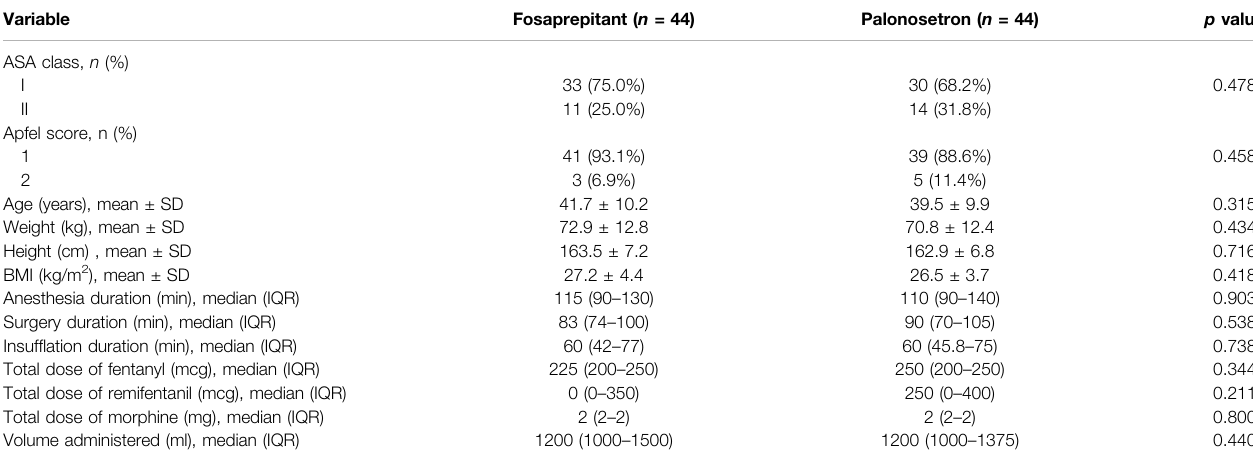
TABLE 1 | Clinical and surgical variables for the treatment groups. Variable